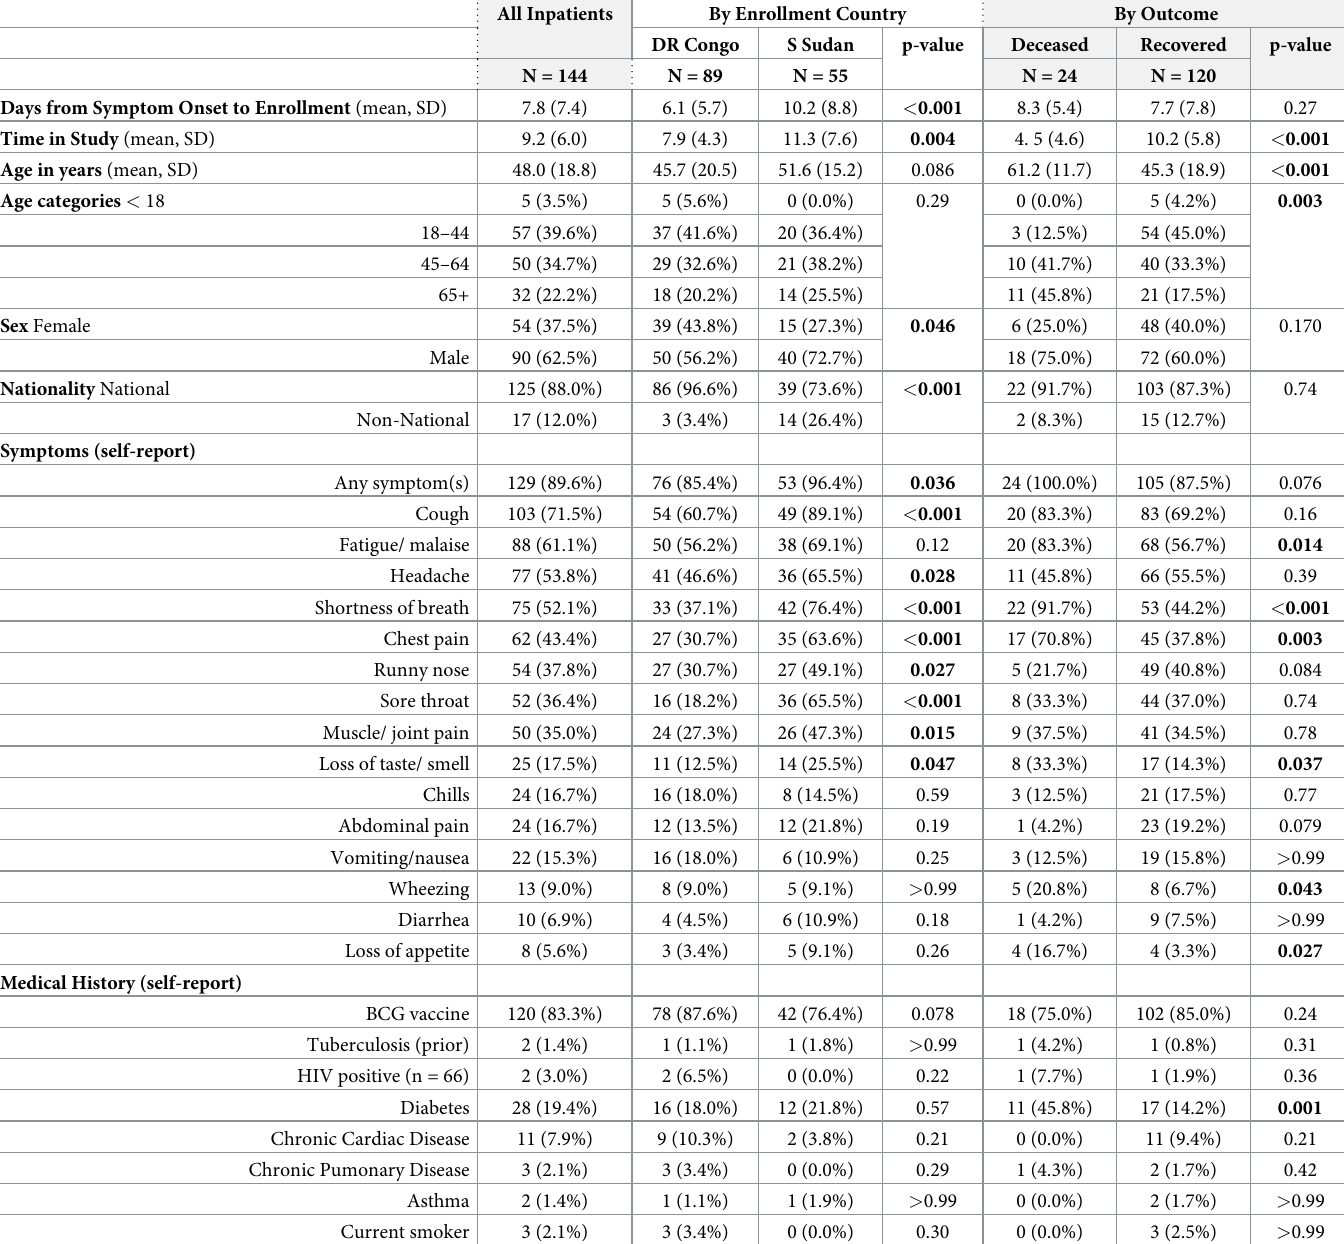
Table 1. Demographic characteristics and self-reported symptoms and health history at